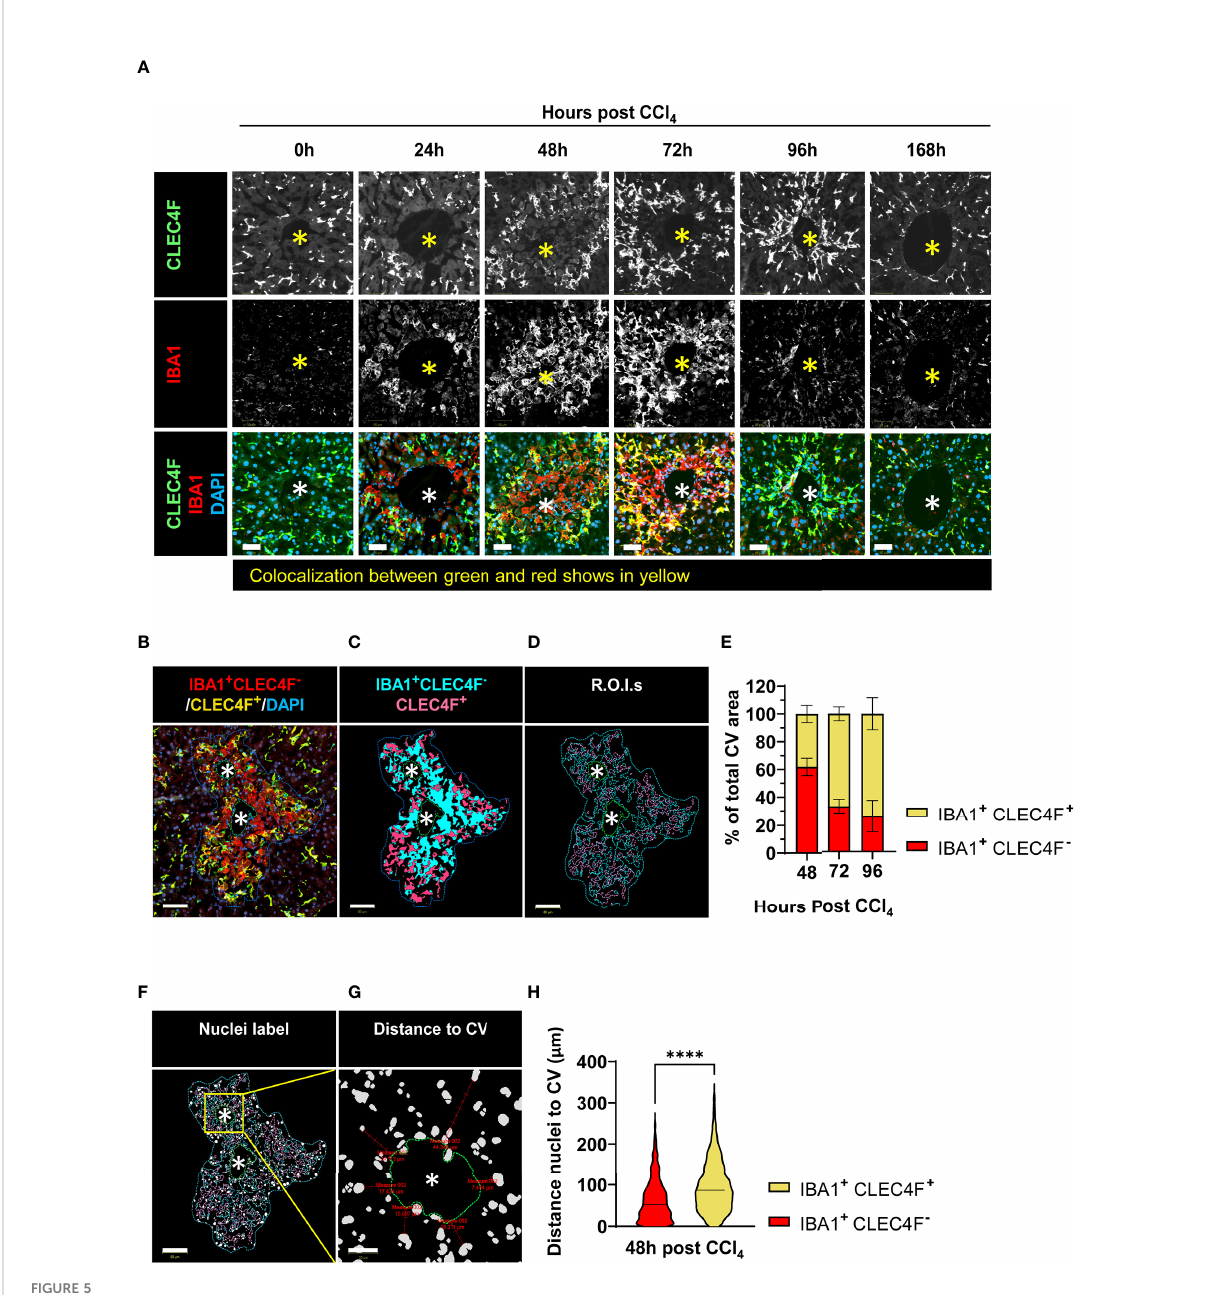
FIGURE 5 CLEC4F + KCs and IBA1 + CLEC4F - macrophages are in close contact in the necrotic area but exhibit different kinetics, microanatomical location, and morphology. (A) Representative mIF images of CLEC4F (green), IBA1 (red) and DAPI (blue) around injured CVs. Top, middle, and bottom rows show CLEC4F single channel (grayscale), IBA1 single channel (grayscale) and merge (CLEC4F in green, IBA1 in red and DAPI in blue), respectively, scale bar =50 m m, * indicates CV. (B) Representative image of CV-associated macrophages at 48 h post-CCl 4 with CLEC4F + KCs in yellow and IBA1 + CLEC4F - macrophages in red, scale bar =80 m m. (C) Digitally generated labels for CLEC4F + KCs (pink) and IBA1 + CLEC4F - macrophages (cyan). (D) Automated outlining of R.O.I. with dotted lines for the necrotic area (blue), CLEC4F + KCs (pink), IBA1 + CLEC4F - macrophages (cyan) and CV (green). (E) Automated measurement of CLEC4F + KCs (pink cells in D) and IBA1 + CLEC4F - macrophages (cyan cells in D) to calculate the percentage of necrotic area occupied by each of these subpopulations. (F) Automated detection of nuclei inside the R.O.I.s. (G) Automated measurement of shortest distance from each nucleus to CV. (H) Quanti fi cation of the distance to the CV from IBA1 + CLEC4F - nuclei vs. IBA1 + CLEC4F + cells nuclei. N=4 mice per group. Data are shown as mean ± SEM, n>4000 nuclei. Statistical analysis was performed using Mann – Whitney U test. ****P <